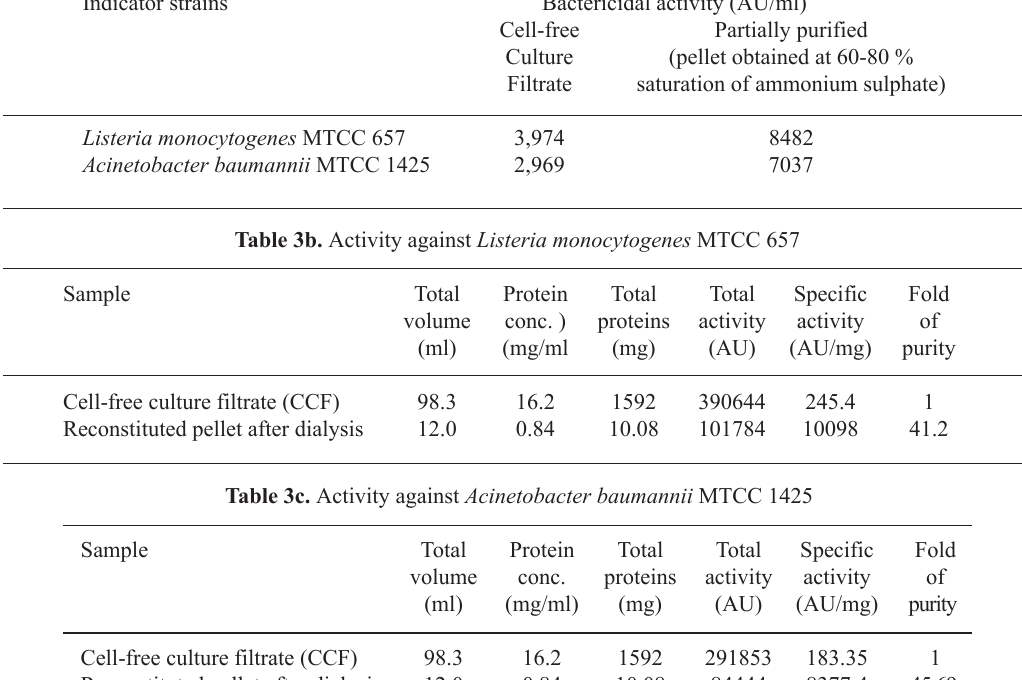
Table 3. Partial purification of bacteriocin from Pediococcus pentosaceus isolated from fermented appam batter by ammonium sulphate precipitation method Table 3a. Purification table of bacteriocin Indicator strains